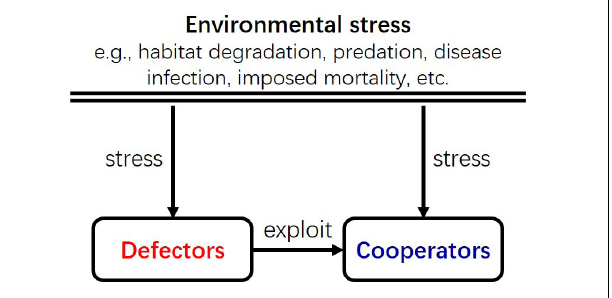
FIGURE 6 | A schematic diagram illustrating the interactions among cooperators, defectors, and the environment. The effect of environmental stress to defectors and cooperators is similar to the cascade effect of trophic interactions in food webs. Environmental stress on defectors indirectly relaxes their exploitation of cooperators, just as the predation on intermediate predators indirectly relaxes the preys at the lower trophic